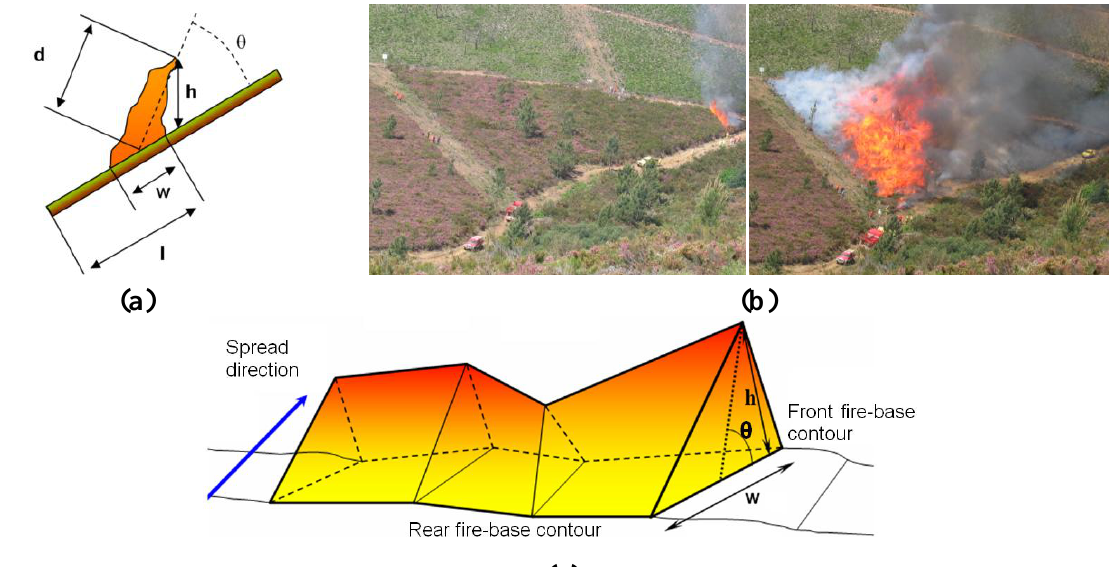
Figure 1. (a) Basic scheme of fire geometrical model. (b) Visual images taken during a field fire experiment. (c) Geometrical model of a fire